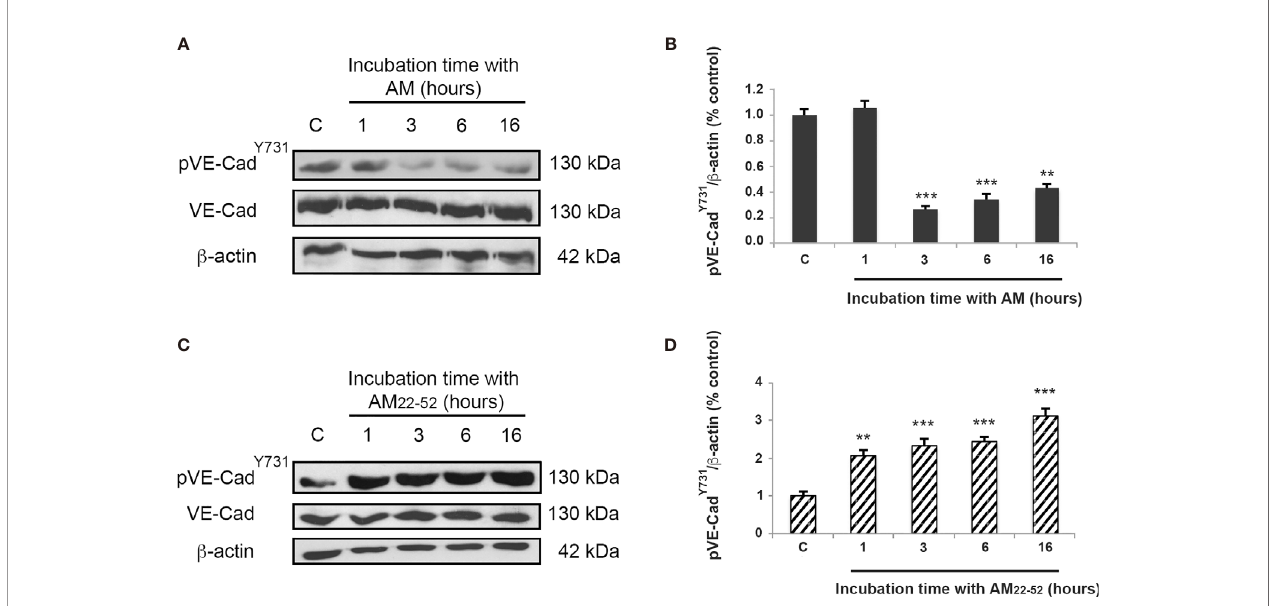
FIGURE 1 | AM induces dephosphorylation of pVE-cadherin Y731 in HUVECs in vitro . (A, C) Total cell lysates isolated from HUVECs treated with AM (10 -9 M) or AM 22-52 (10 -6 M) were subjected to immunoblotting for VE-cadherin and pVE-cadherin Y731 , as indicated. (A, B) AM (10 -9 M) signi fi cantly decreases the phosphorylation of VE- cadherin Y731 in a time-dependent manner. (C, D) AM 22-52 (10 -6 M) increases phosphorylation of VE-cadherin Y731 in a time-dependent manner. Blotting for b -actin was used to control equal loading. Molecular weights are indicated. ** p < 0.01; *** p < 0.001. Each experiment is representative of ten (B, D) independent experiments. Results are shown as means ±